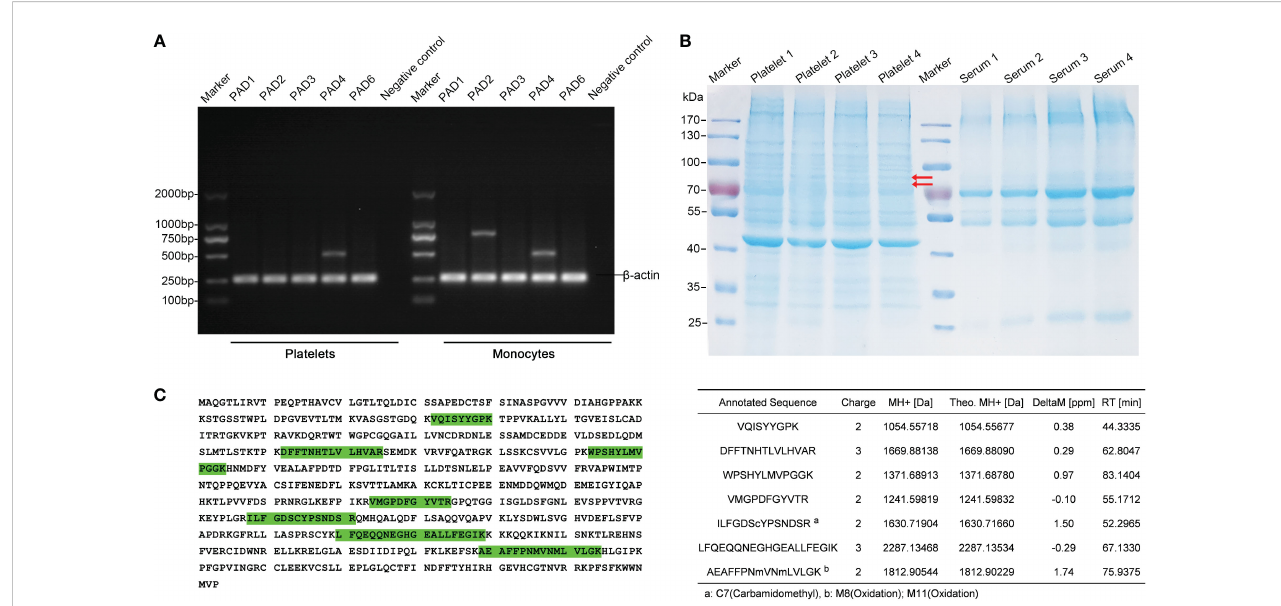
FIGURE 1 Identi fi cation of PAD4 expression in the human platelets. (A) Agarose gel electrophoresis of RT-PCR products after amplifying the mRNA of PAD isoforms in platelets and monocytes. The b -actin expression was used as an internal control. PCR without the template served as a negative control. (B) SDS- PAGE depicting the proteins from platelets. Lanes 2-5 are corresponding to platelet samples divided into 20 slices from top to bottom, followed by an in gel-digestion and LC-MS/MS analysis. Arrow indicates PAD4 expression in the gel by MS analysis. Lanes 7-10, show the paired serum samples indicating the limitation present in the carry-through of plasma proteins into platelet proteomics. (C) Detected PAD4 peptide sequence coverage. Left section: the identi fi ed tryptic peptides are indicated in green shadow. Right section: list of detected and mapped